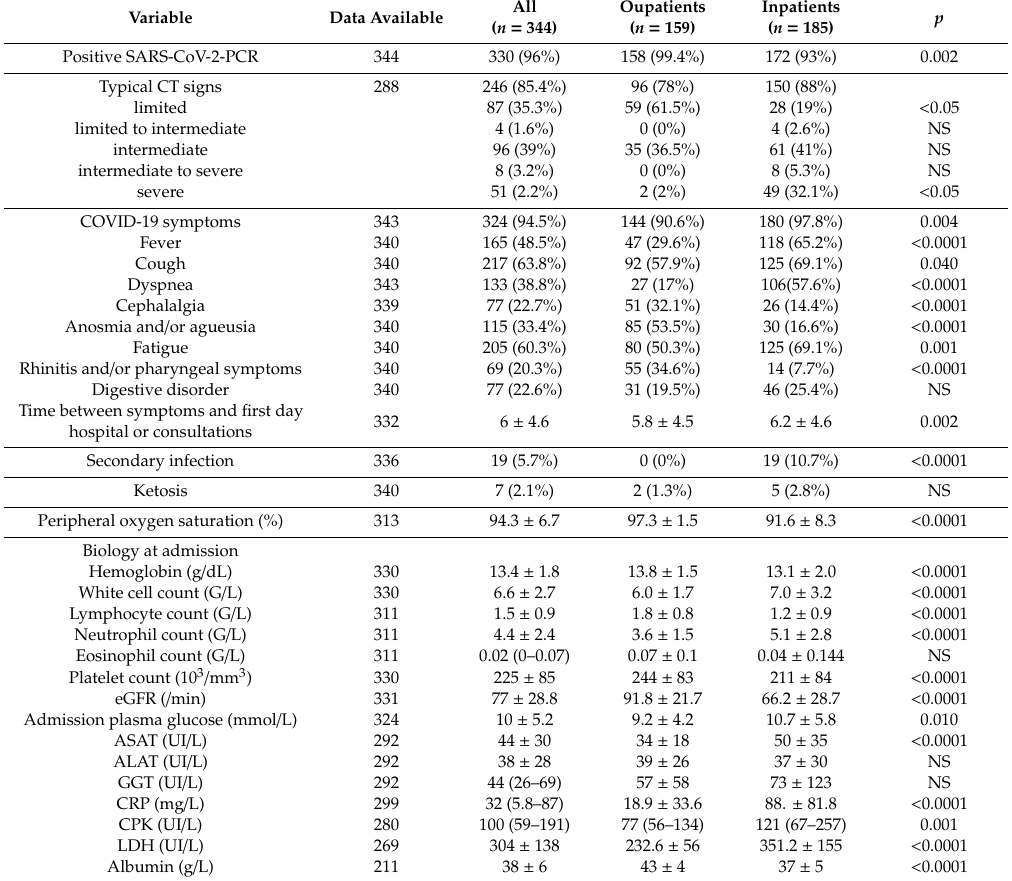
Table 2. COVID-19-related clinical, radiological, and biological characteristics on first examination (at the emergency department unit or